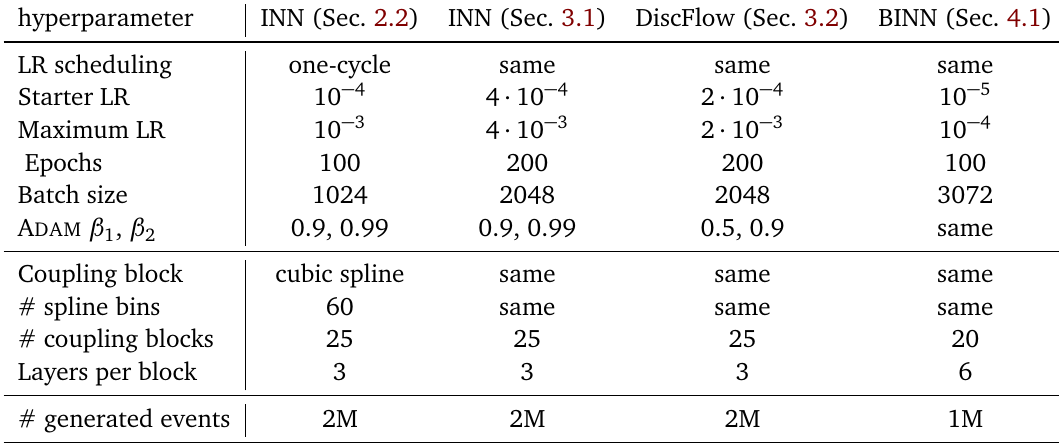
Table 1: Training setup and hyperparameters for the INN generators used in our different